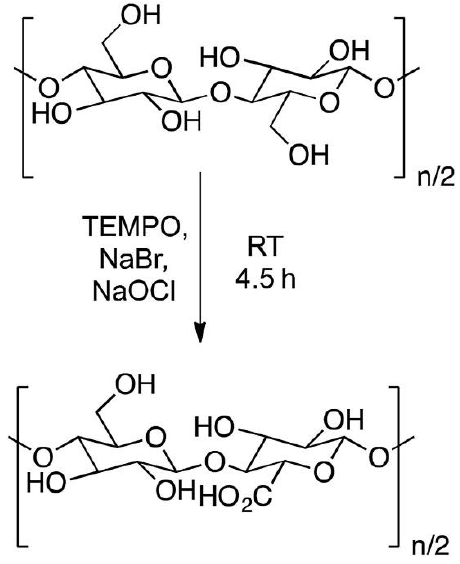
Figure 3. TEMPO oxidation of MxG-CNC to MxG-CNC-COOH.